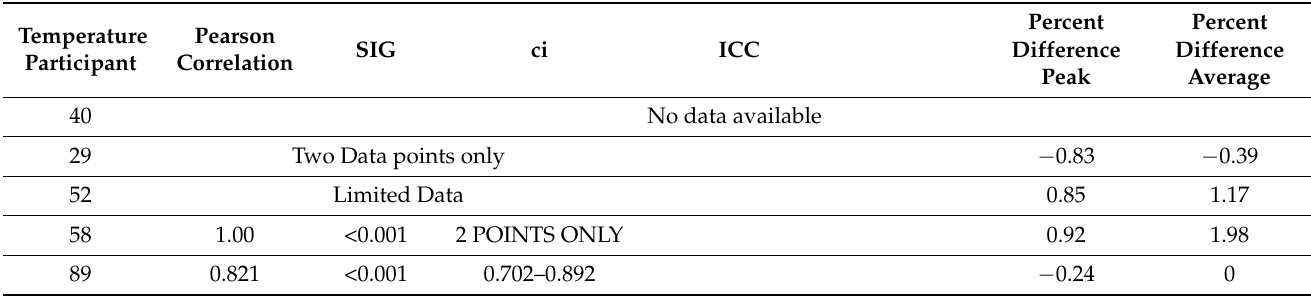
Table 4. Correlation between Slate Safety and ingestible pill and percentage difference .